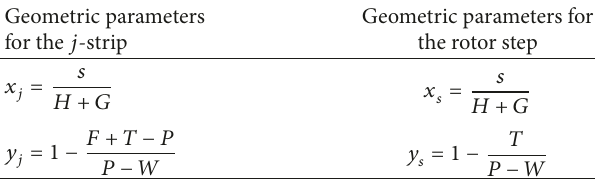
Figure 13: Surface fitting of the discharge coefficients for the short teeth with the geometrical parameters. Table 4: Nomenclature of the geometric parameters defined in Table